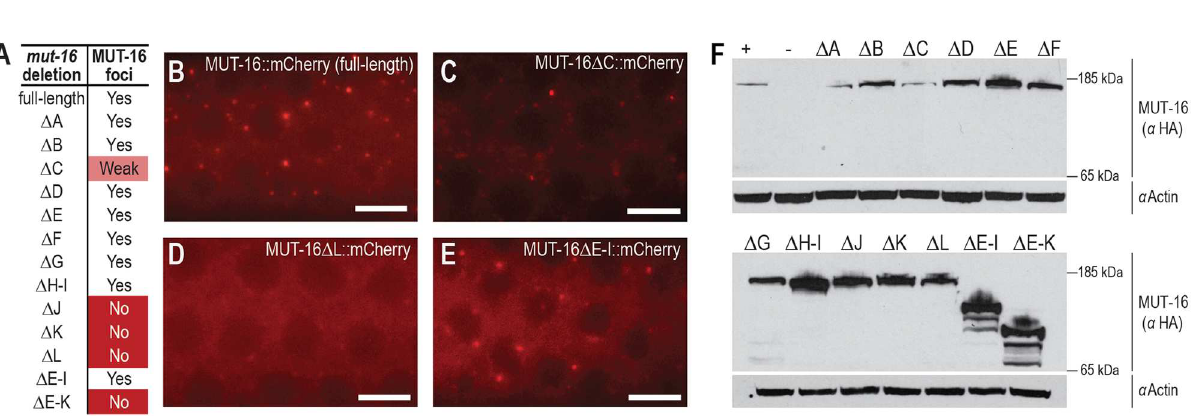
2 , rde-2 , mut-14 smut-1 , and mut-15 . Of the genes tested, only mut-16 was required for RRF-1 localization (S2B Fig). Localization of RDE-8 and NYN-1 to Mutator foci requires both mut-16 and mut-15 . To determine if NYN-1 or RDE-8 were required for each other’s localization we